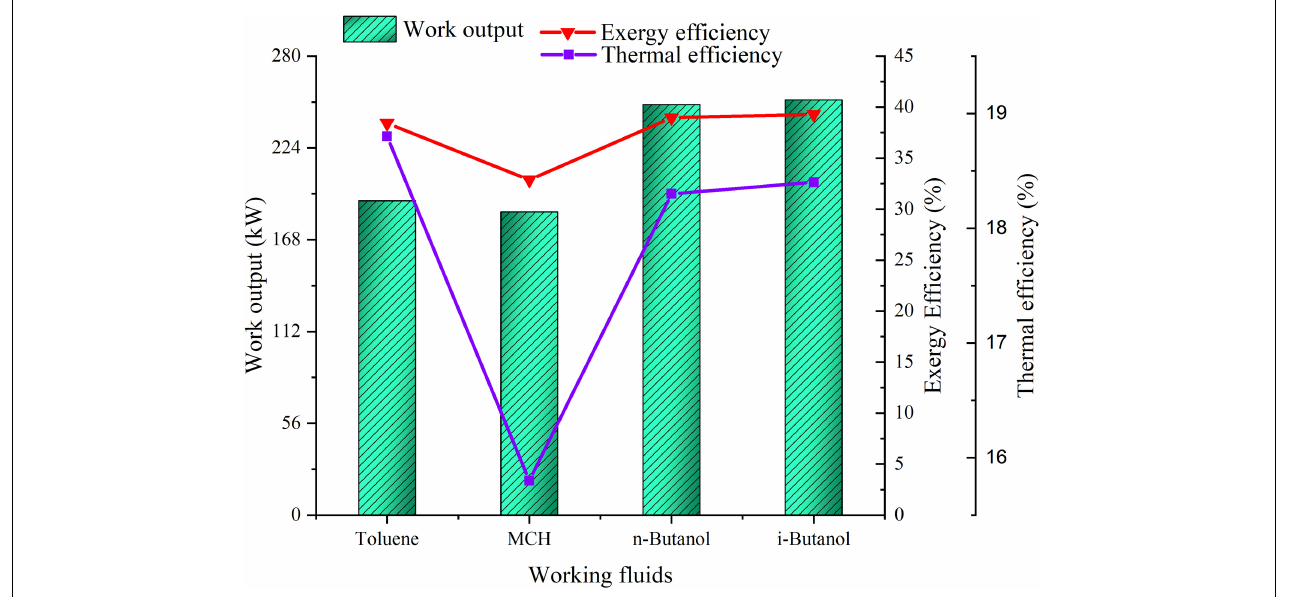
FIGURE 7 | Work output, thermal efficiency, and exergy efficiency of working fluids.